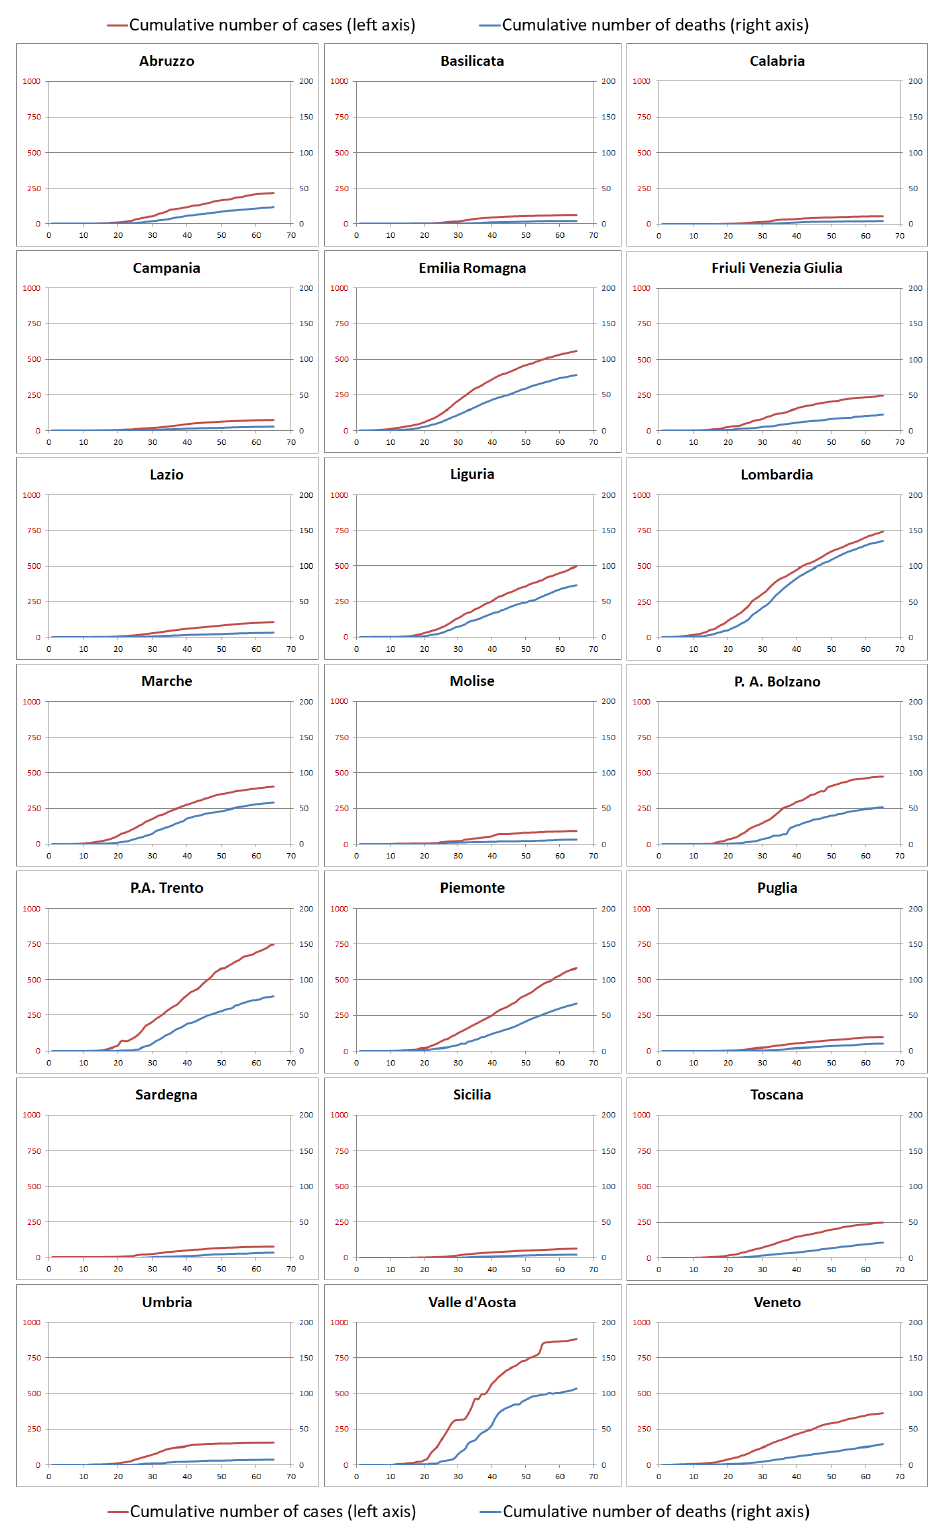
Figure 2. Cumulative number of cases (red lines and left scales) and deaths (blue lines and right scales) over time in each region per 100,000 inhabitants.